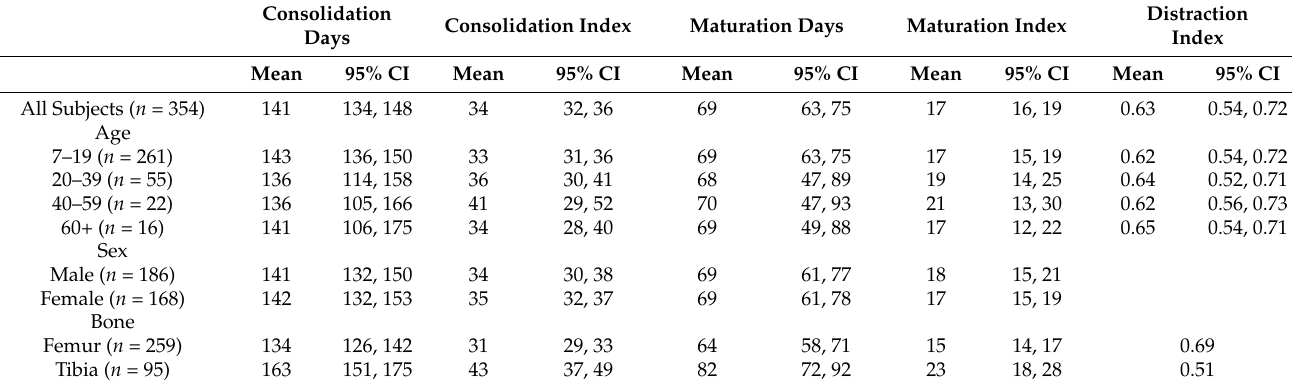
Table 2. Healing